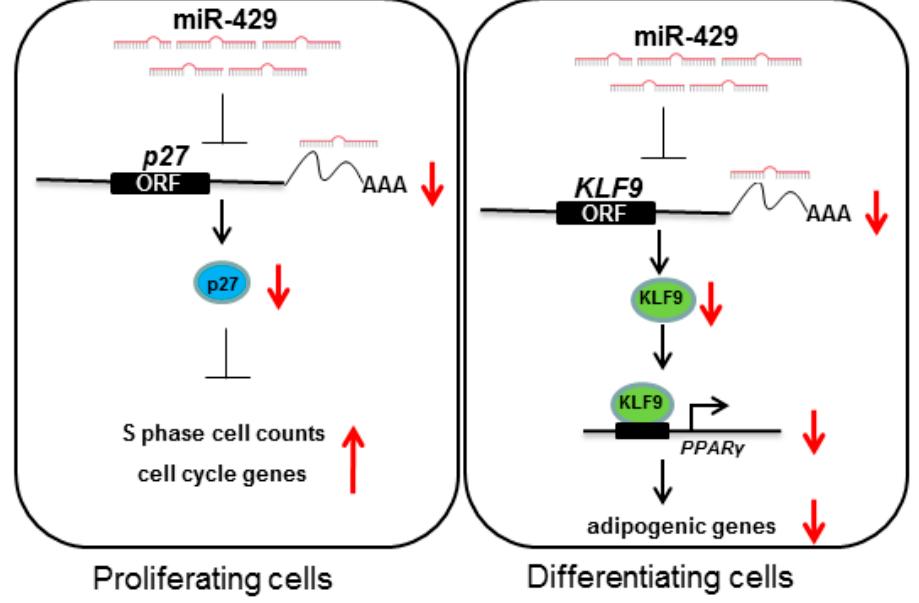
Figure 8. Schematic diagram of cellular mechanism of porcine preadipocytes by miR-429. During porcine preadipocyte proliferation, miR-429 can target on p27 3 ′ -UTR to inhibit its expression, then the decreased p27 promote entry and/or progression of S phase [30] and increase the expression of cell cycle genes; During porcine preadipocyte differentiation, miR-429 can target on KLF9 3 ′ -UTR to suppress its expression. The reduced KLF9 might inhibit the transcription activity of PPAR γ promoter [29]. Then the expression of downstream adipogenic genes were restrained. Red upward arrow means this process is promoted; red downward arrow means this process is inhibited.